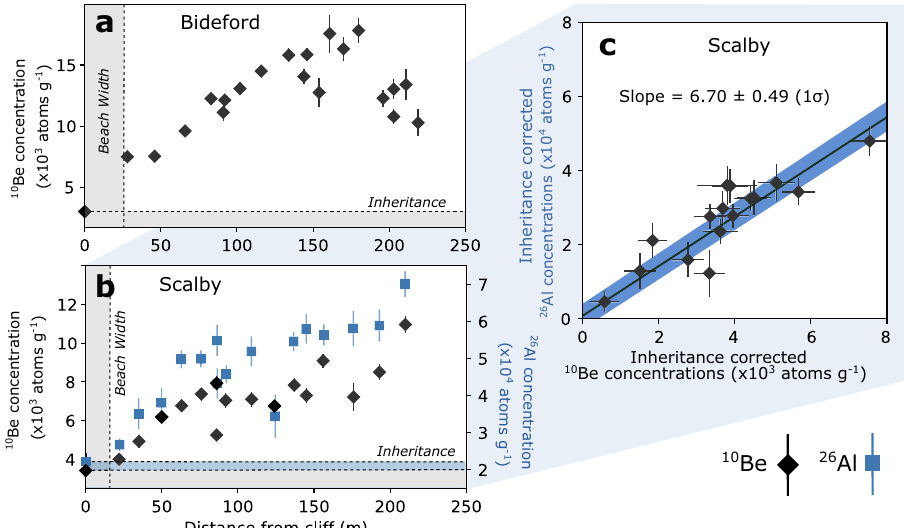
Fig. 2 | Measured cosmogenic radionuclide (CRN) concentrations. a Measured 10 Be concentrations at Bideford with distance from the cliff base (1 σ ). b Measured 10 Be and 26 Al concentrations at Scalby with distance from the cliff base (1 σ ).